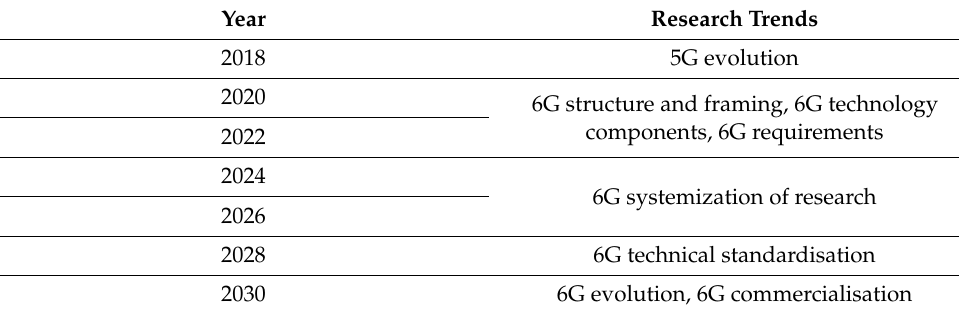
Table 1. The 5G and 6G research trends from 2018 to